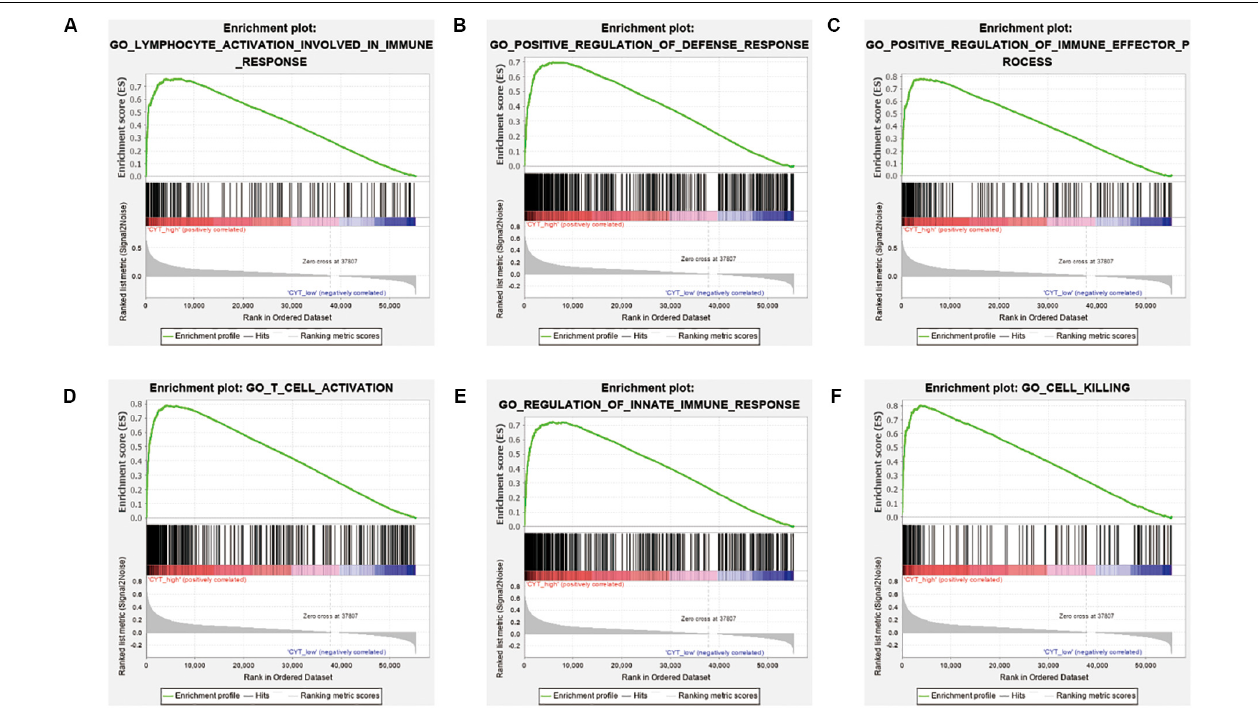
FIGURE 6 | Different immune phenotypes between high- and low-CYT score groups in TCGA-PRAD cohort. (A–F) Gene set enrichment analysis for comparing immune phenotype between high- and low-CYT score groups. Significant enrichment of CYT score related GO terms in high CYT score